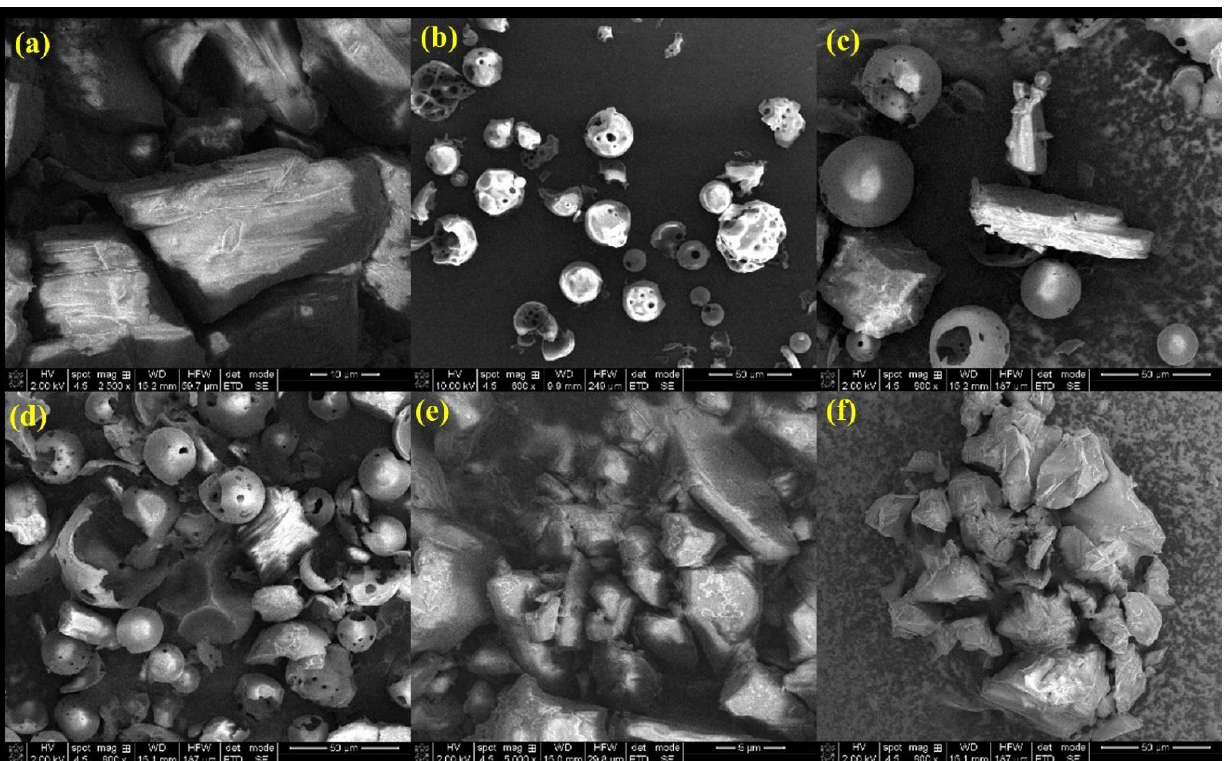
Figure 3. SEM images of ( a ) AML, ( b ) HP- β -CD, ( c ) AML-HP- β -CD physical mixture, ( d ) AML-HP- β -CD kneading method, ( e ) AML-HP- β -CD coprecipitation method, and ( f ) AML-HP- β -CD lyophilization method.